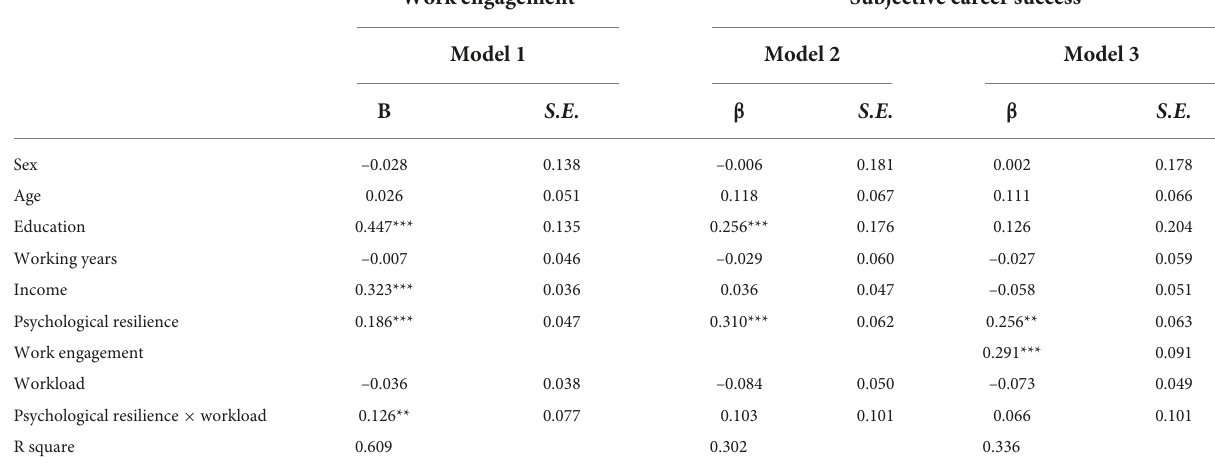
TABLE 4 Results of regression analysis for hypothesis